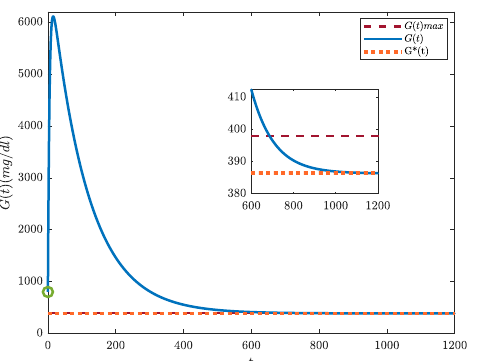
Figure 2. Numerical simulation for type-1 diabetes mellitus system (1)–(5): Solution for G ( t ) (plasma glucose level), taking initial conditions I ( t ) = 10, Y ( t ) = 10, D ( t ) = 800, G ( t ) = 800, and U ( t ) = 550, and parameter values of Table 1. G ∗ ( t ) is the equilibrium point, and G max is the upper bound.